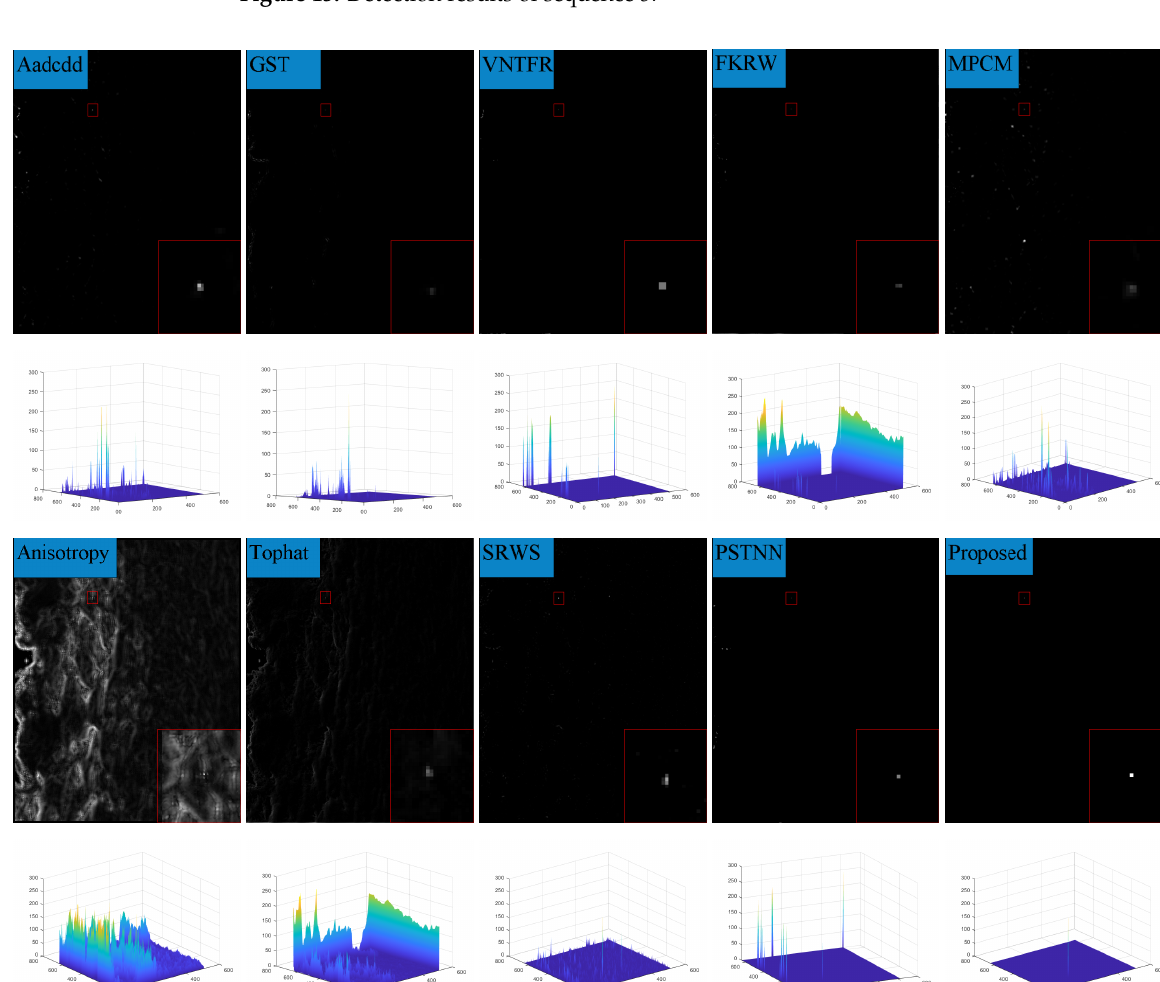
Figure 14. Detection results of sequence